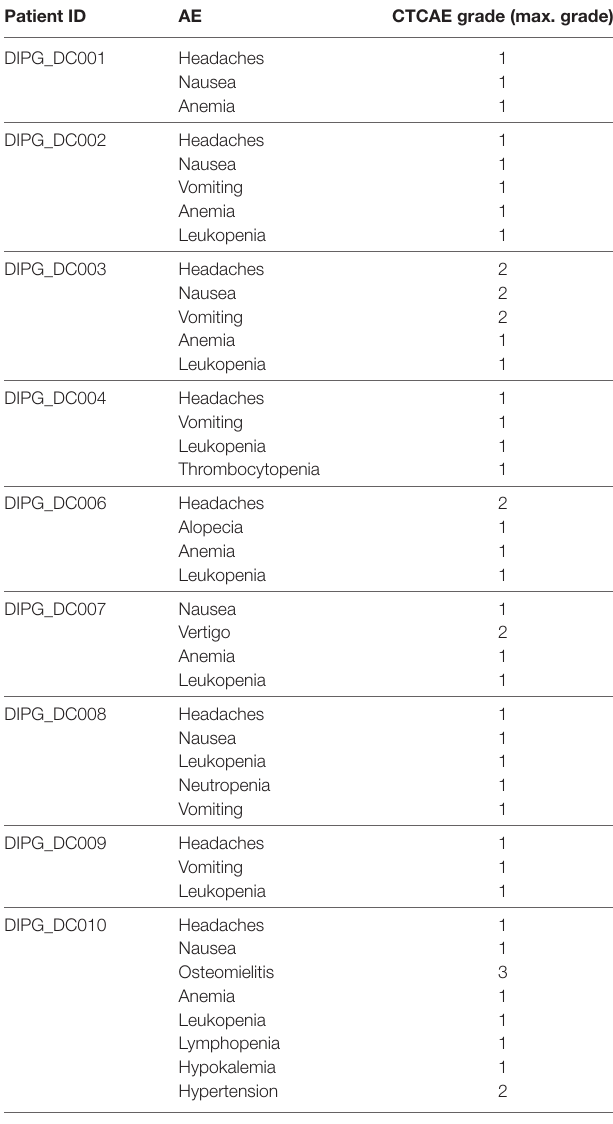
TaBlE 2 | Adverse events (AEs). Patient